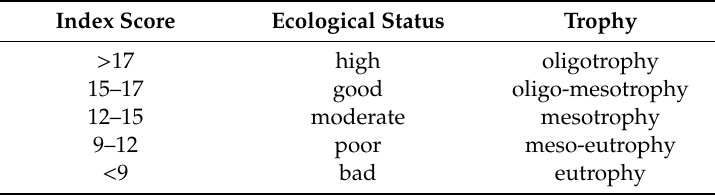
Table 2. Class limit values for diatom indices according to